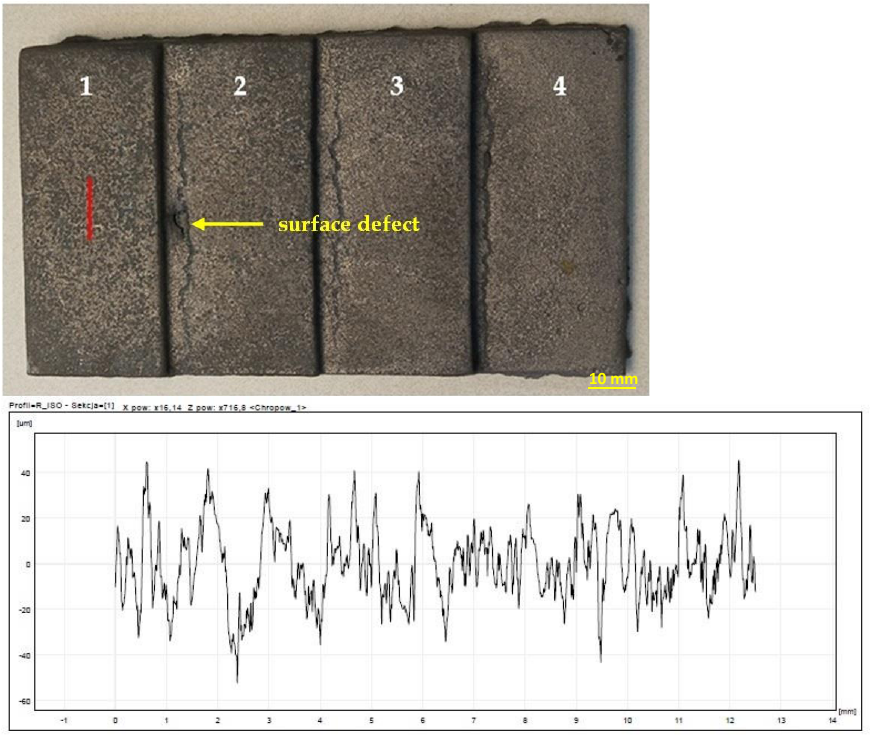
Figure 16. Raw casting made in a mold with a mass of MB 5%. A chart of an example of surface roughness for the 1st “stair” of the casting. 1 – 4 are numbers of stairs of the casting.